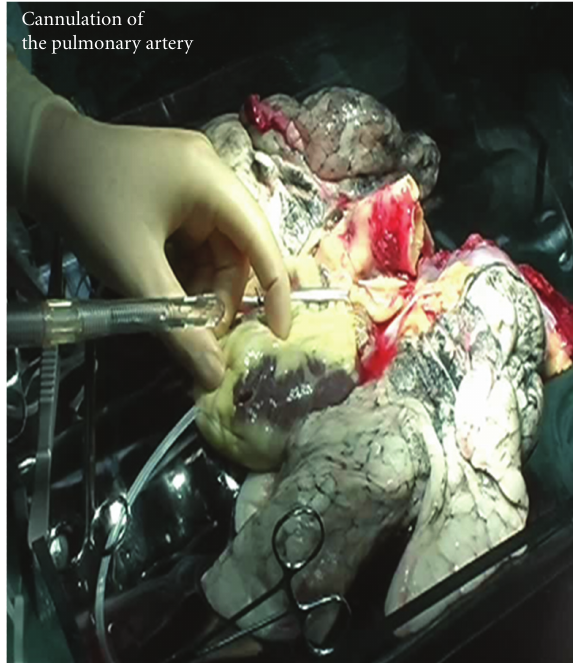
Figure 2: Schematic (a) and photograph (b) of the ex vivo lung reconditioning and evaluation system. The blood leaving the remaining dorsal part of the left atrium runs freely out into the box containing the lung. The pulmonary arterial pressure (PAP) is measured continuously. The left atrium pressure (LAP) is maintained at 0mmHg. Blood gases are measured in the blood before and after the lung. The system is primed with STEEN solution and erythrocyte